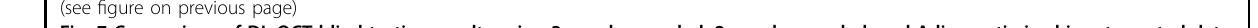
= 407 spectral data points per A-line; spec